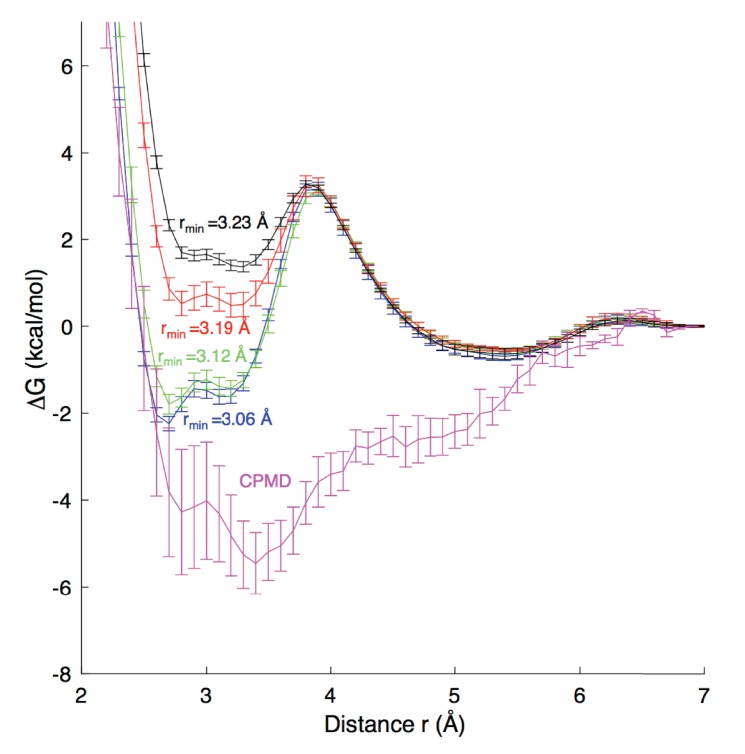
Free energy profiles for Na+ - carboxylate binding with different pair parameters, compared to CPMD quantum mechanical calculations.Estimated dissociation constants (KD) for each MD model are: CHARMM27 (rmin = 3.06 Å) 0.6 ± 0.2 M; CHARMM27* (rmin = 3.12 Å) 0.9 ± 0.2 M, CHARMM27* NBFIX (rmin = 3.19 Å) 1.8 ± 0.2 M; and CHARMM27* NBFIX (rmin = 3.23 Å) 1.8 ± 0.3 M; to be compared with experimental values discussed in the Appendix.